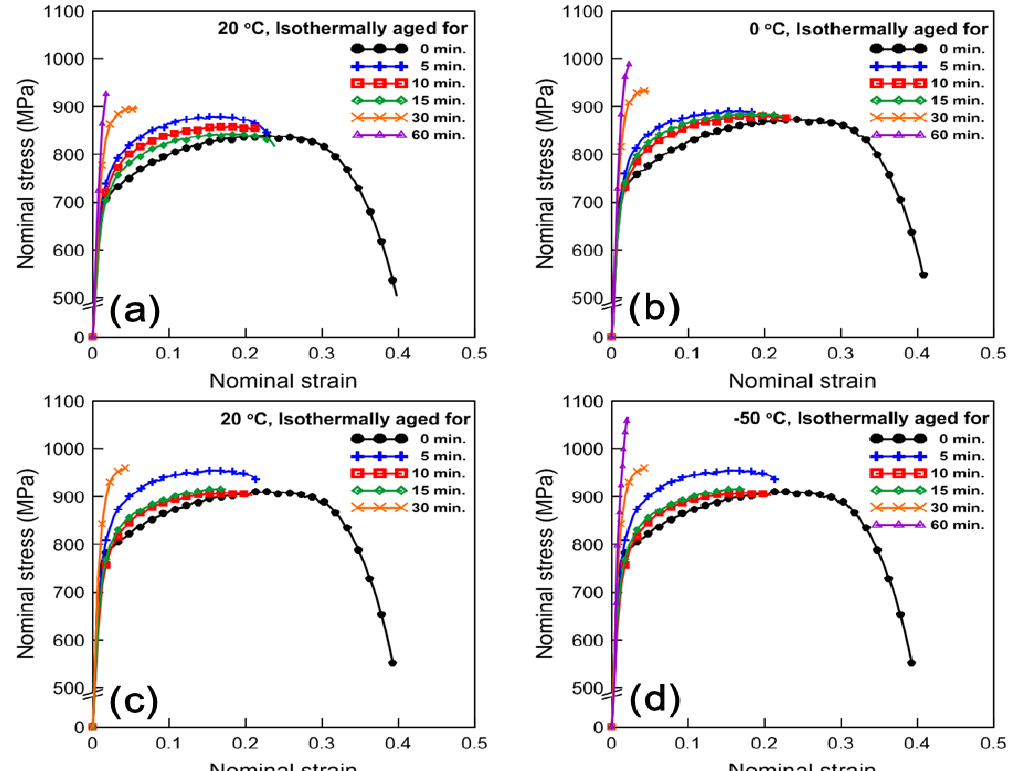
Figure 5. Nominal stress-strain curves of SDSS with tensile test temperature ( a ) 20 °C; ( b ) 0 °C; ( c ) −20 °C and ( d ) −50 °C.